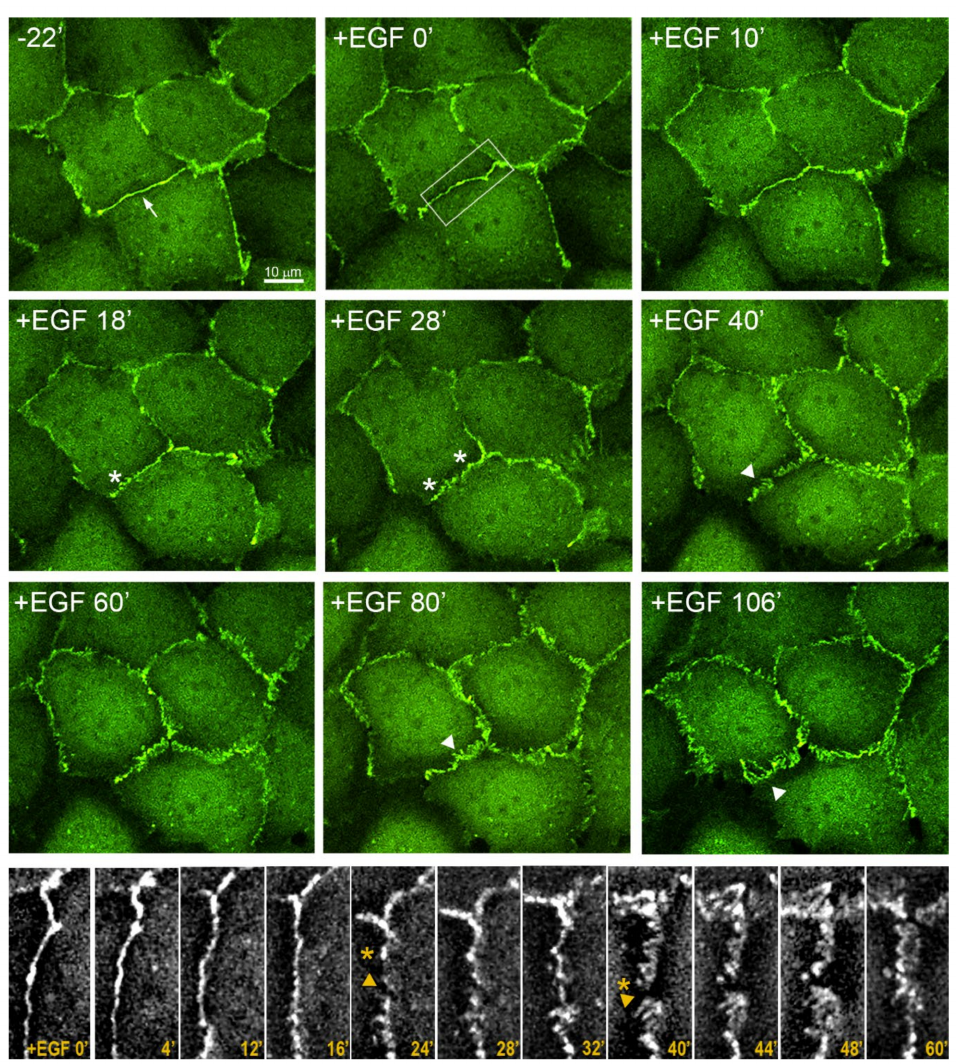
Figure 6. Rearrangement of AJs in EGF-treated IAR-20 cells. IAR-20 cells were stably transfected with GFP-E-cadherin. Top—in the presence of EGF, the linear AJs are replaced with punctate AJs. The arrow indicates linear AJs, asterisks indicate dotlike clusters, and arrowheads indicate punctate AJs. The boxed area denotes the cell-cell boundary enlarged in the bottom part. Selected frames from Video S6. Bottom—in EGF-treated cells, AJs are very dynamic. AJs can grow, rearrange, and change their position. Arrowheads indicate disassembly of AJs; asterisks indicate newly formed dotlike AJs. Selected frames from Video S7. A corresponding DIC image demonstrating the integrity of the monolayer is shown in Figure